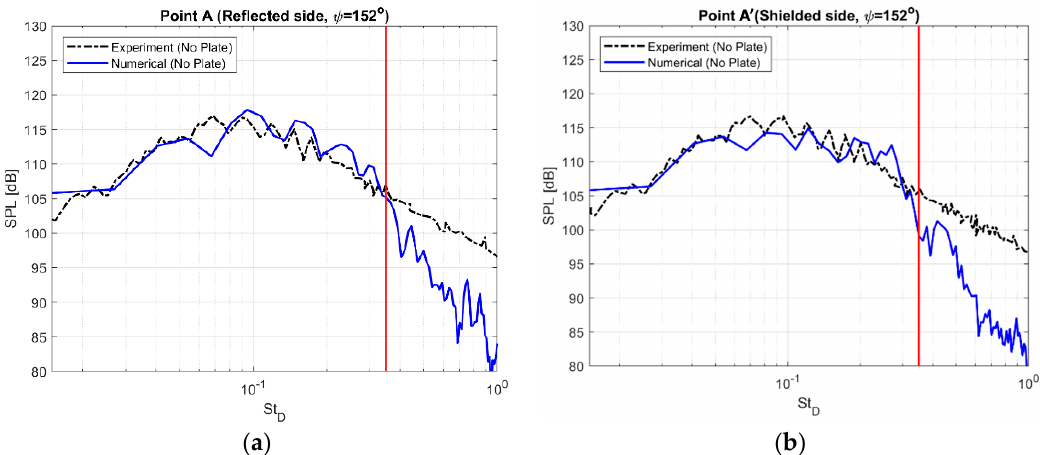
( b ) Figure 28. Instantaneous fluctuating pressure, (cid:1868) (cid:4593) [(cid:1842)(cid:1853)] . ( a ) Baseline (BSL) case, ( b ) Shielded case. For the spectral data presented here, 4 bins of 1024 samples are collected at a sampling frequency of 204.8 kHz . A Hanning window function, along with a 25% overlap for each segment, is used and fast Fourier transform (FFT) is applied to obtain the sound pressure level (SPL) ( (cid:1856)(cid:1828) (cid:1870)(cid:1857)(cid:1864) 20 μPa ) spectrum. The frequency is non-dimensionalized and represented as the Strouhal number, as explained in the earlier sections. The hydraulic diameter, (cid:1830) , and the isentropic exhaust velocity, (cid:1847) (cid:3037) , of the jet are used as the length scale and velocity, respectively, for the calculation of the Strouhal number. Figure 29 compares the SPL spectra between the reflected side and the shielded for the free jet